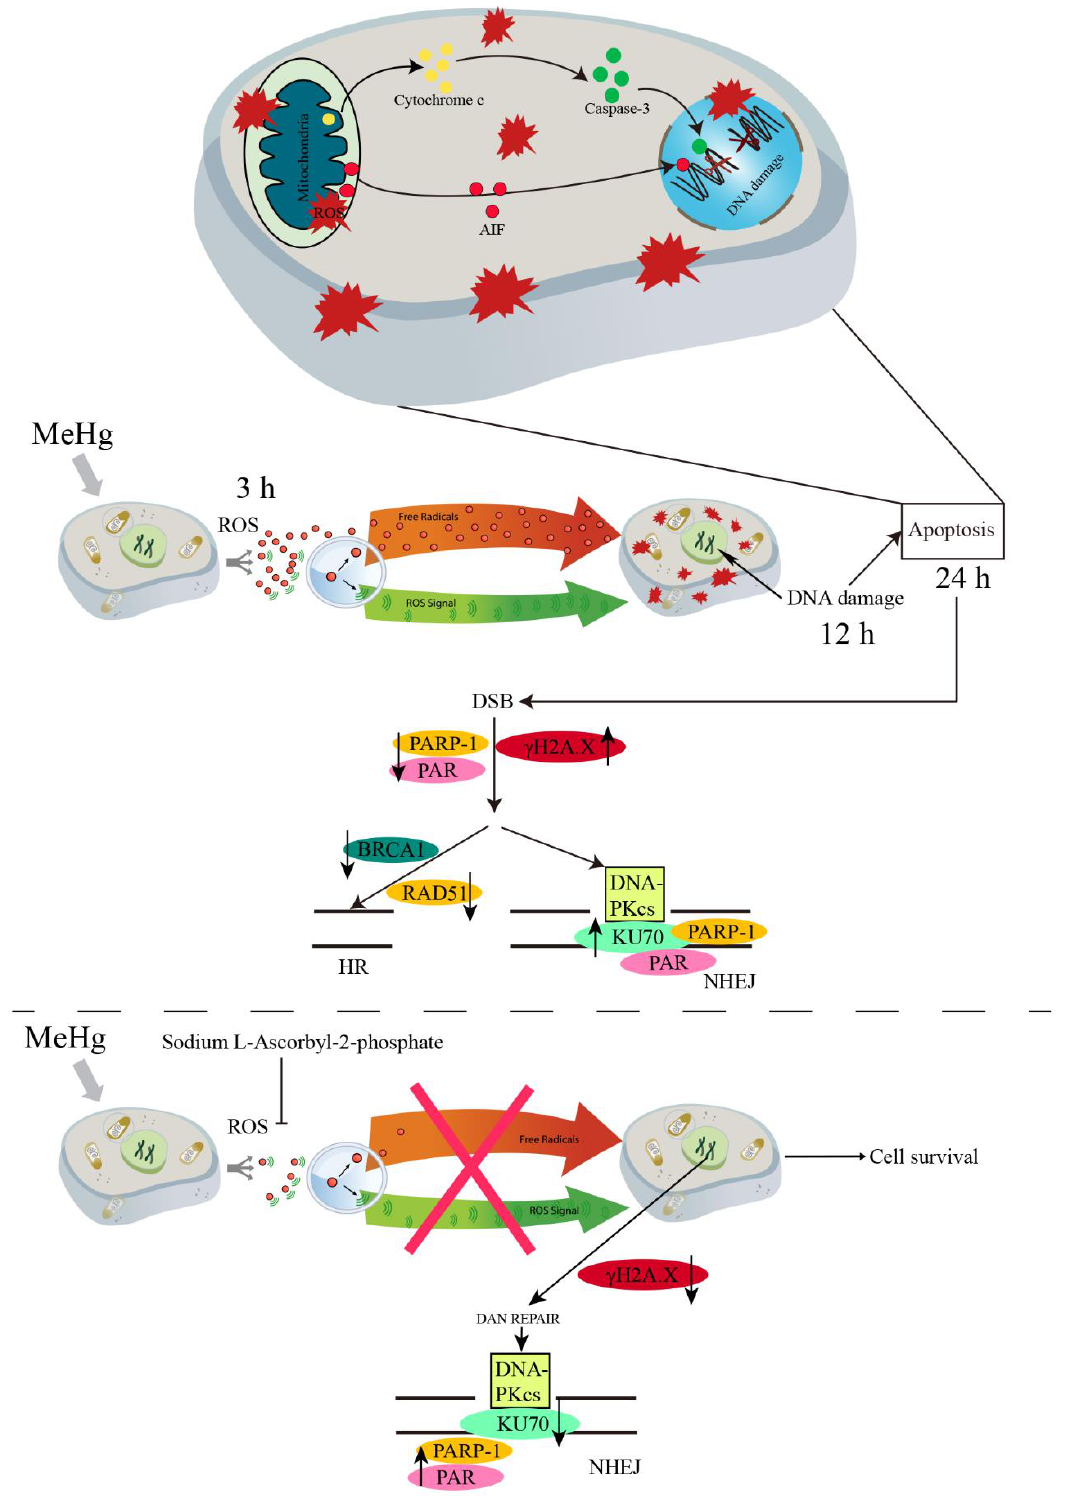
Figure 7. Schematic representation of the effects of MeHg and AA2P on SH-SY5Y cells. AA2P reduces MeHg-induced damage and apoptosis in SH-SY5Y cells by attenuating ROS-mediated DNA damage and downregulating NHEJ repair-related protein KU70.